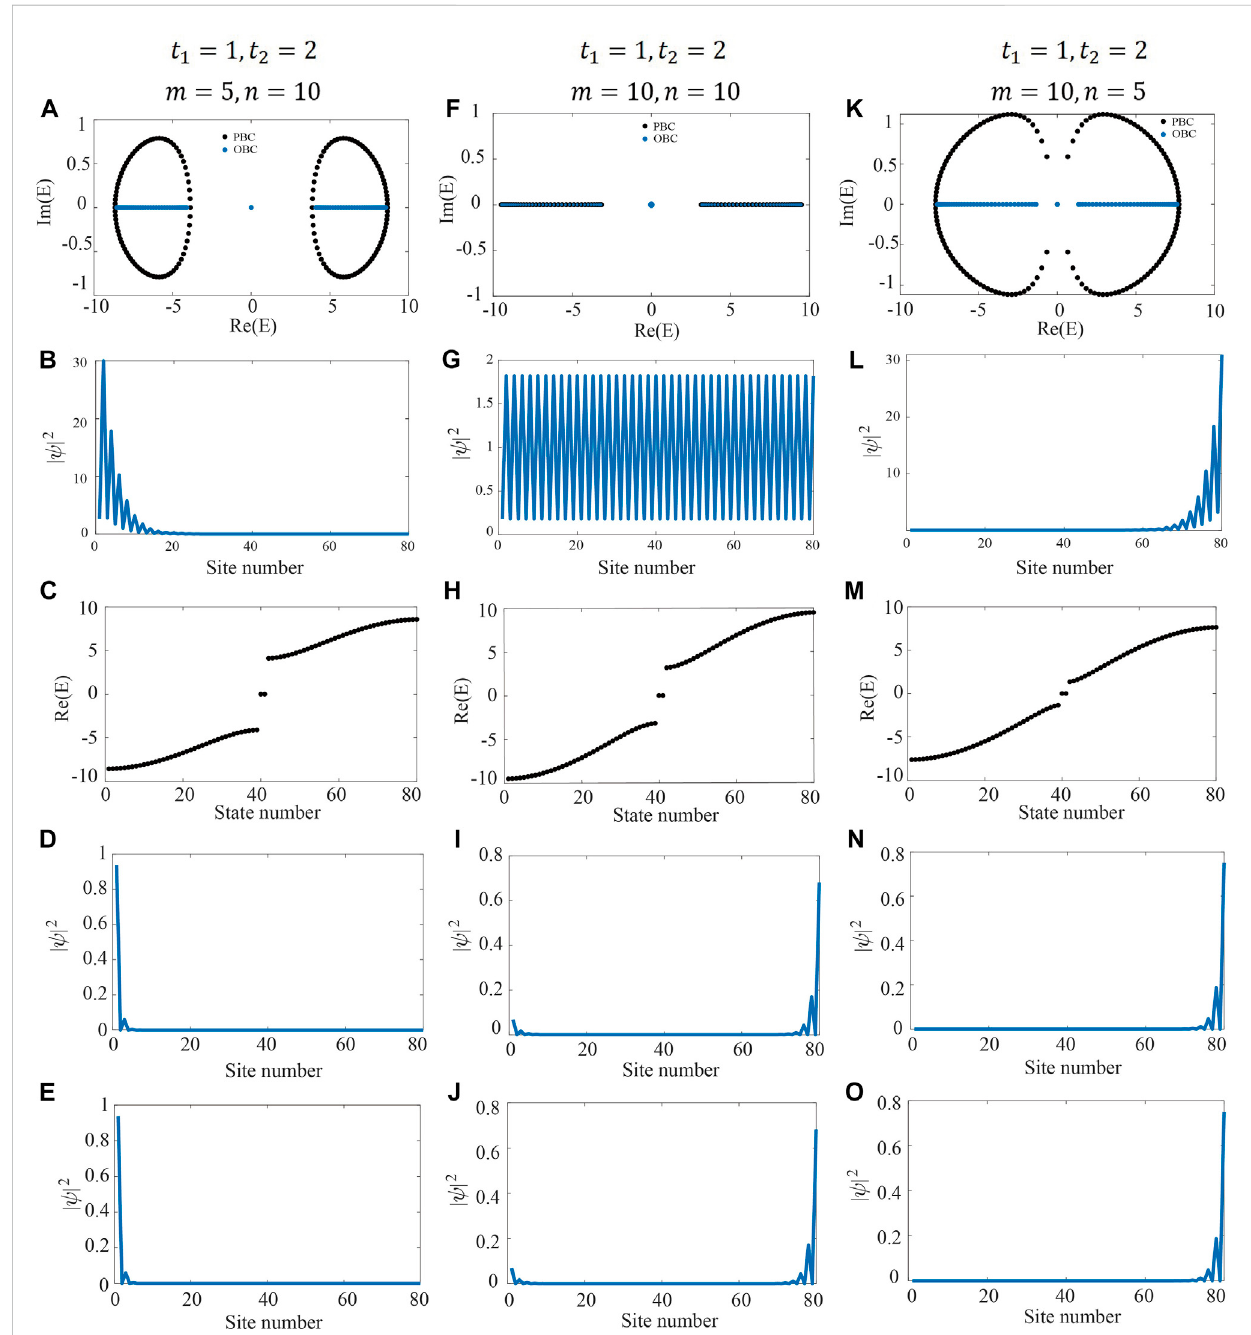
FIGURE 2 We consider three sets of m and n with t 1 (cid:1) 1 and t 2 (cid:1) 2. In subpictures (A) – (E) , we respectively plot and show theenergy spectra, summed intensity pro fi le of all the eigenstates, the real part of eigen energy and intensity pro fi le of in-gap eigenstates in the scenario of m (cid:1) 5 , n (cid:1) 10. Similar calculations are also conducted and the results are displayed in (F) – (J) and (K) – (O) separately for the cases of m (cid:1) 10 , n (cid:1) 10 and m (cid:1) 10 , n (cid:1) 5. The energy spectra in complex-energy planes under the condition of t 1 (cid:1) 1, t 2 (cid:1) 2 are very similar to those in the schemes of t 1 (cid:1) 2, t 2 (cid:1) 1 except for the emergence of zero-energy eigenstates, which essentially are topological states and can be understandable due to larger intercell hopping ( t 2 ) over the intracell ( t 1 )